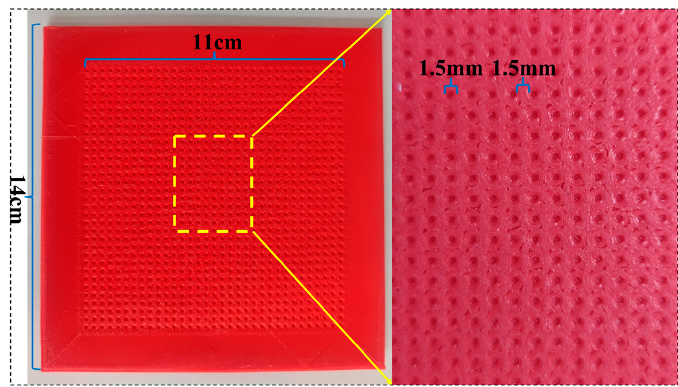
Figure 1. Actual image of microstructure mold.